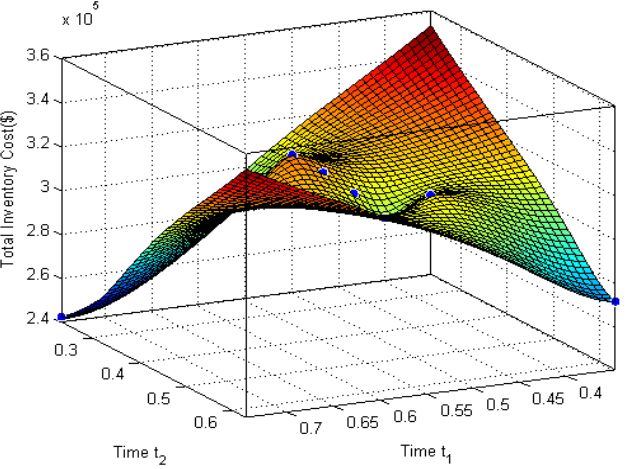
Figure 11. Total inventory cost vs. time t 1 and time t 2 .